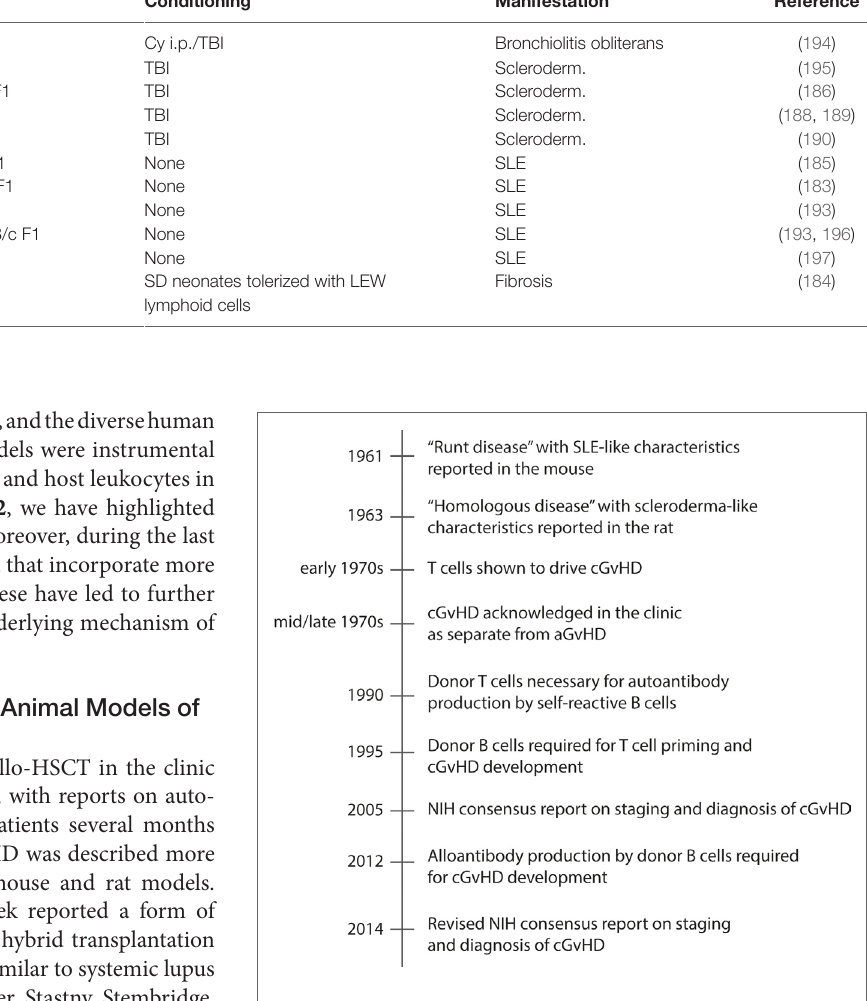
FiGURe 2 | Timeline of major events in cGvHD research using animal models . Chronic GvHD is characterized by autoantibody production and deposition in target tissues, and tissue fibrosis. The timeline presents how animal models have contributed to increased understanding of the pathology of cGvHD, and included is also the NIH consensus reports on staging and diagnosis of cGvHD, which has contributed to development of improved rodent models of cGvHD during the last decade.